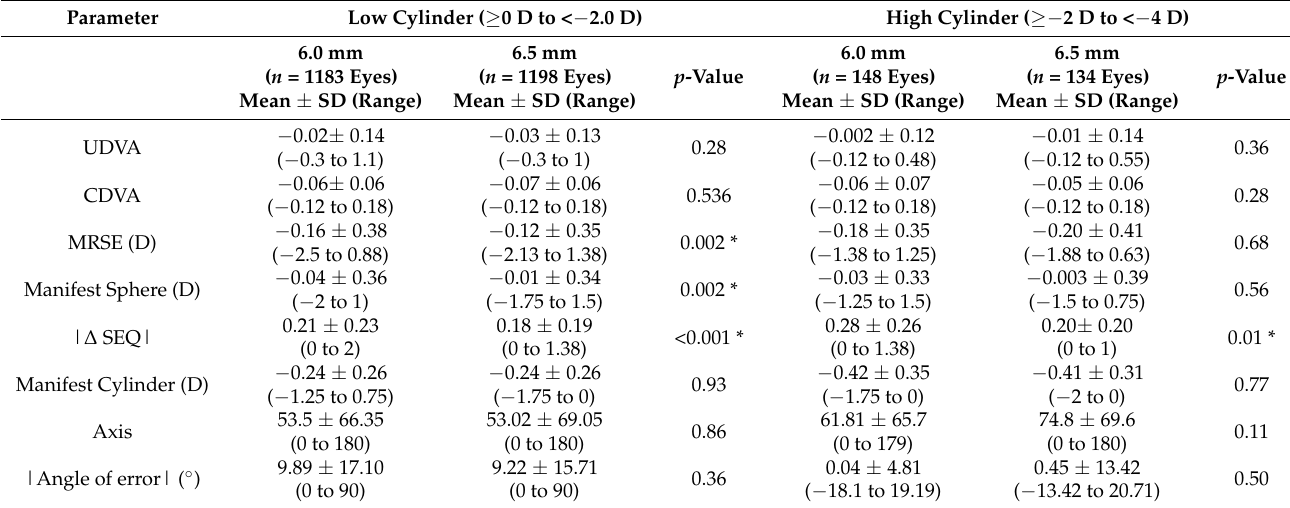
Table 4. Postoperative results stratified by severity of